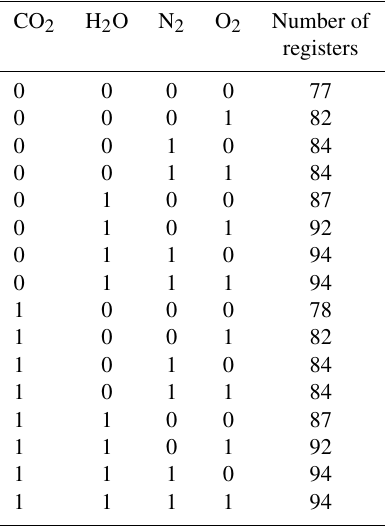
Figure 5. Data flow graph for the most important sub-kernels in JURASSIC. Data items are shown as ovals independent of whether they are stored in memory or exist only as intermediate results. Sub-kernels are depicted as rectangles. The arrow labels indicate the data sizes in units of kibibytes. The example refers to a nadir use case considering a single trace gas (CO 2 ) and 32 instrument channels. Figure adapted from Baumeister et al. (2017).